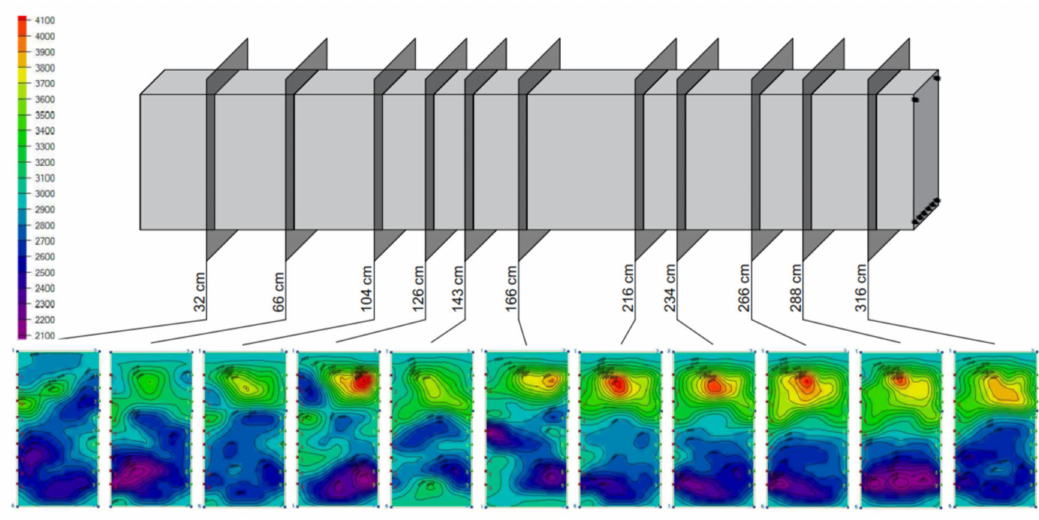
Figure 7. Tomography maps of the